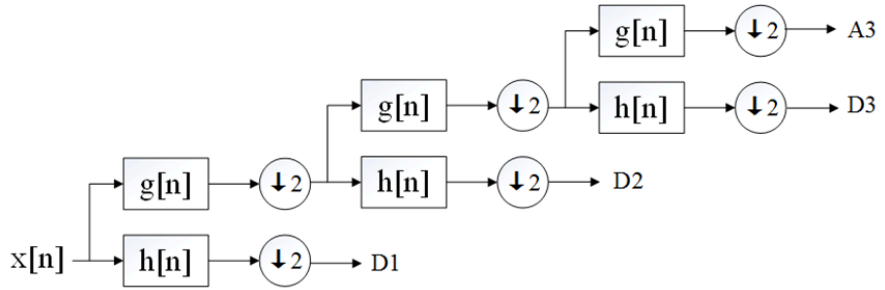
Figure 1. wavelet decomposition.